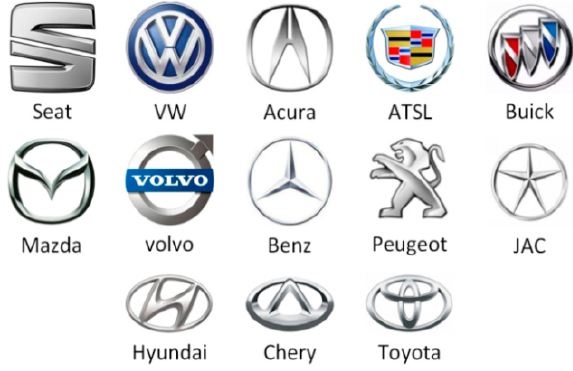
Figure 8. Samples of 13 logo classes.